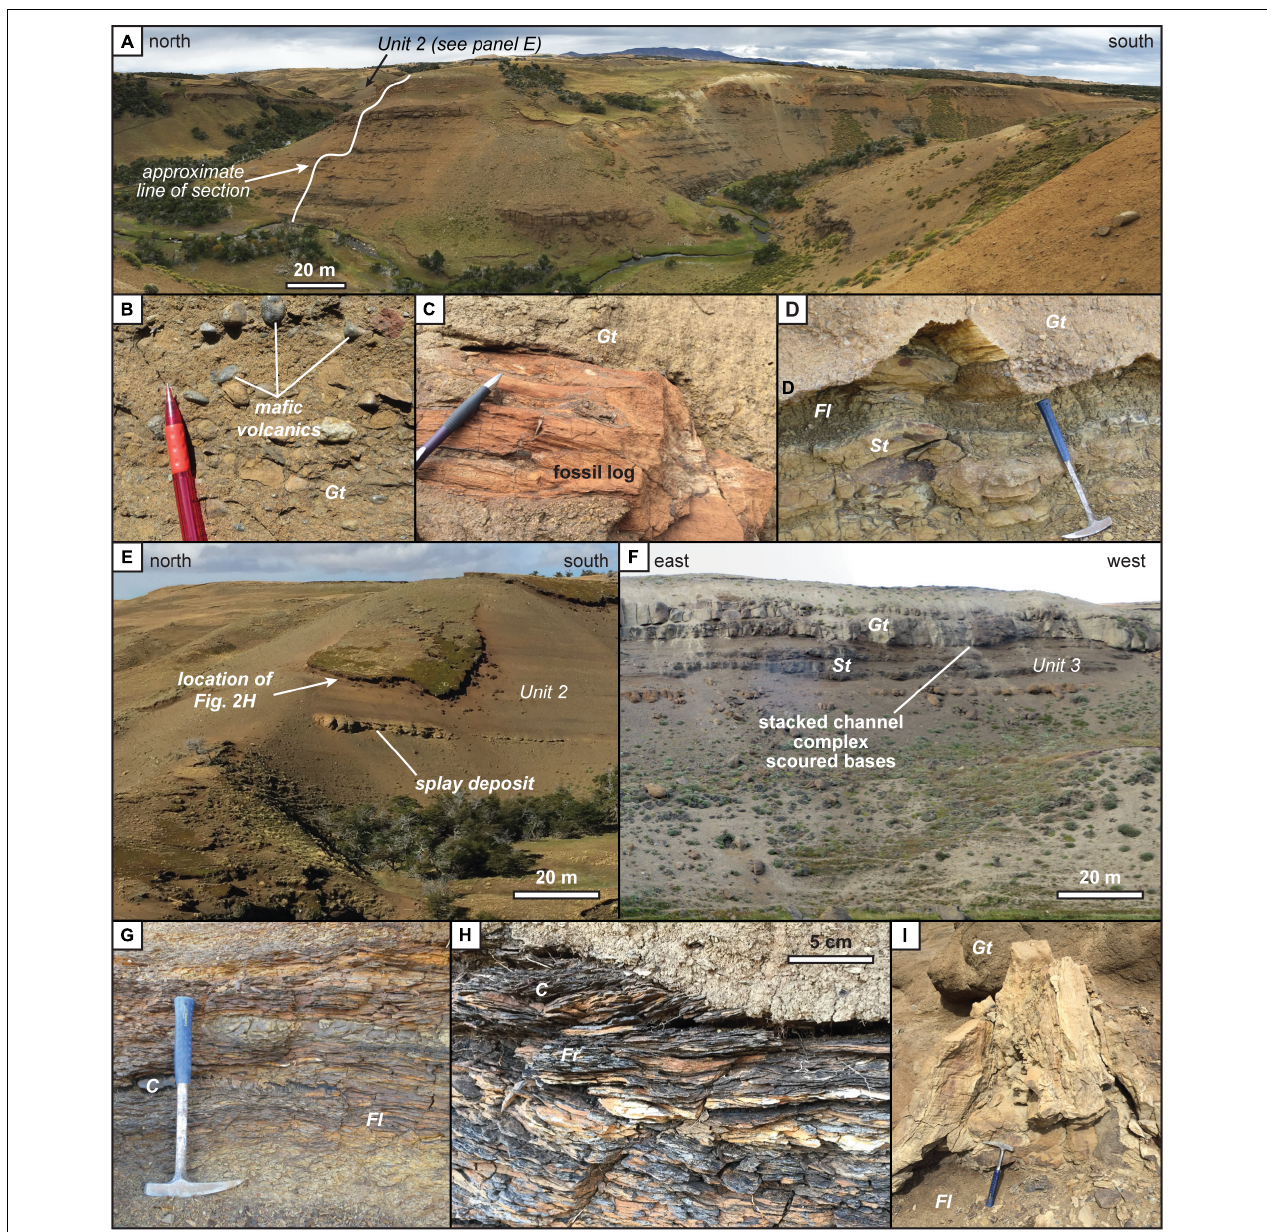
FIGURE 2 | Representative outcrops of the Río Guillermo Formation at the Cancha Carrera study area. (A) Panoramic basinward view of Unit 1 showing channelized Gt conglomerate and St sandstone and fine-grained, slope-forming strata ( Fl, C ). White line depicts location of part of the measured section in Figure 3 . (B) Representative clasts from a Gt bed from Unit 1. (C) Petrified wood encased within Gt conglomerate in Unit 1. (D) Erosive base of channelized Gt strata into underlying fine-grained strata in Unit 1. (E) Panoramic basinward view of Unit 2 showing mostly interbedded mudstone and siltstone with sparse channelized Gt , Gh , Gt deposits. White line depicts location of part of the measured section. (F) Panoramic view of Unit 2 showing channelized Gt and St beds and recessive slope-forming St and Sl strata. (G,H) Fine-grained St , Fl , and C of Unit 2. (I) Fossilized tree trunk in life position, rooted in fine-grained St and Fl and buried by channel Gt deposits of Unit 3. See Table 2 for lithofacies